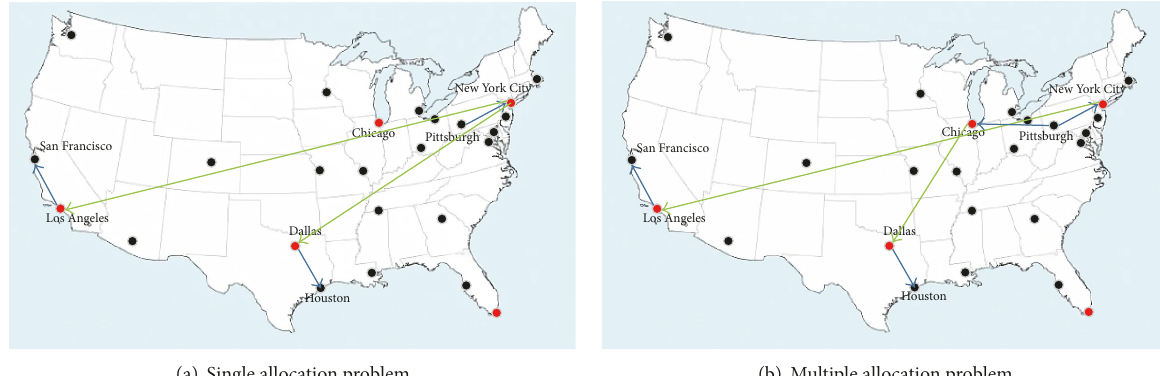
Figure 1: Single allocation problem and multiple allocation problem: (a) Flights from Pittsburgh must go through its hub New York City first for different destinations in single allocation problems. (b) The flow can be assigned to New York City for destination of San Francisco and to Chicago for destination of Houston in multiple allocation